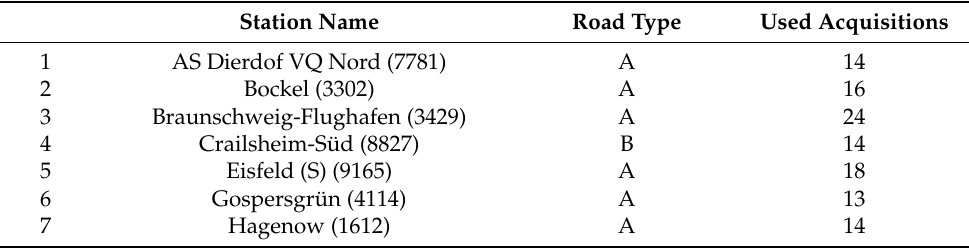
Table A2. BAST traffic count stations and number of used Sentinel-2 acquisitions for the valida- tion